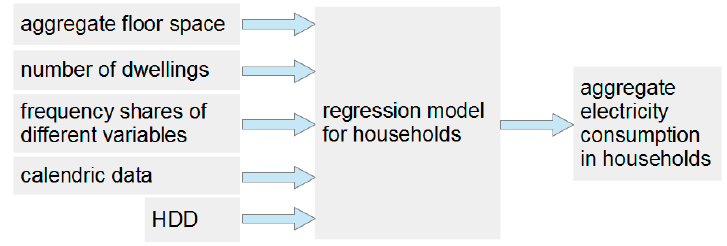
Figure 4. Modeling aggregate hourly electricity consumption in the household sector.